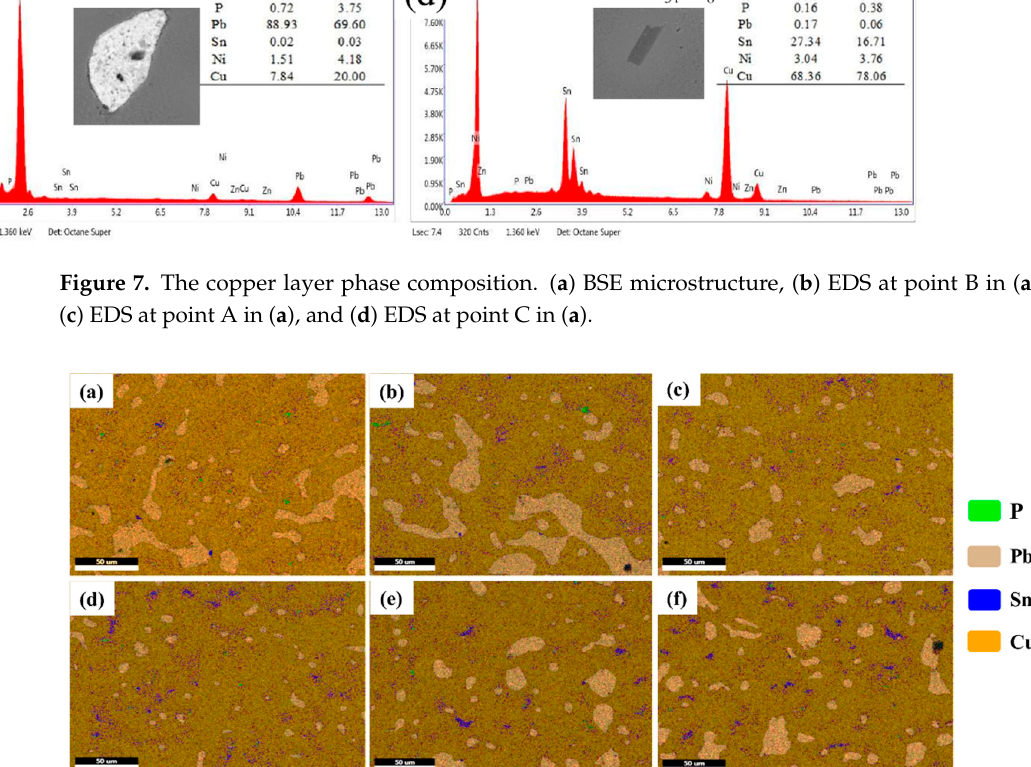
Figure 7. The copper layer phase composition. ( a ) BSE microstructure, ( b ) EDS at point B in ( a ), ( c ) EDS at point A in ( a ), and ( d ) EDS at point C in ( a ).